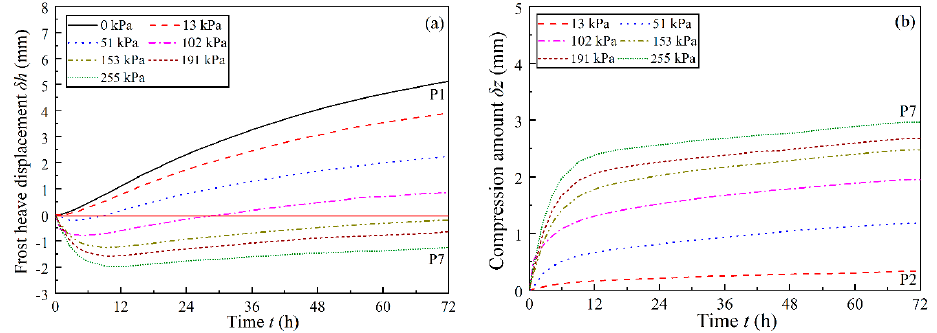
Figure 4. Variations in the frost heave displacement ( a ) and compression amount with freezing time under external pressures ( b ).